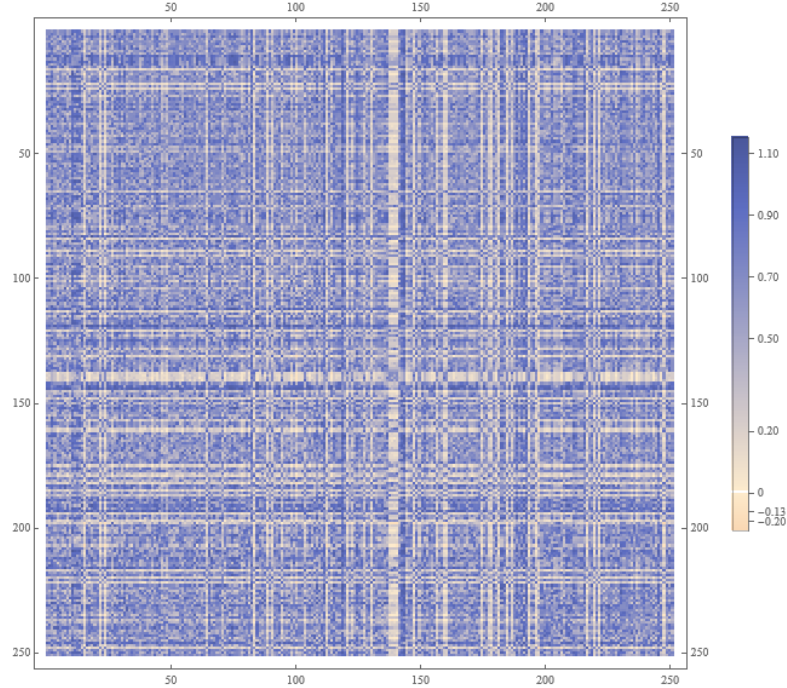
Figure 10. Kernel matrix for the 2018 economic stress period with biweekly sliding window.